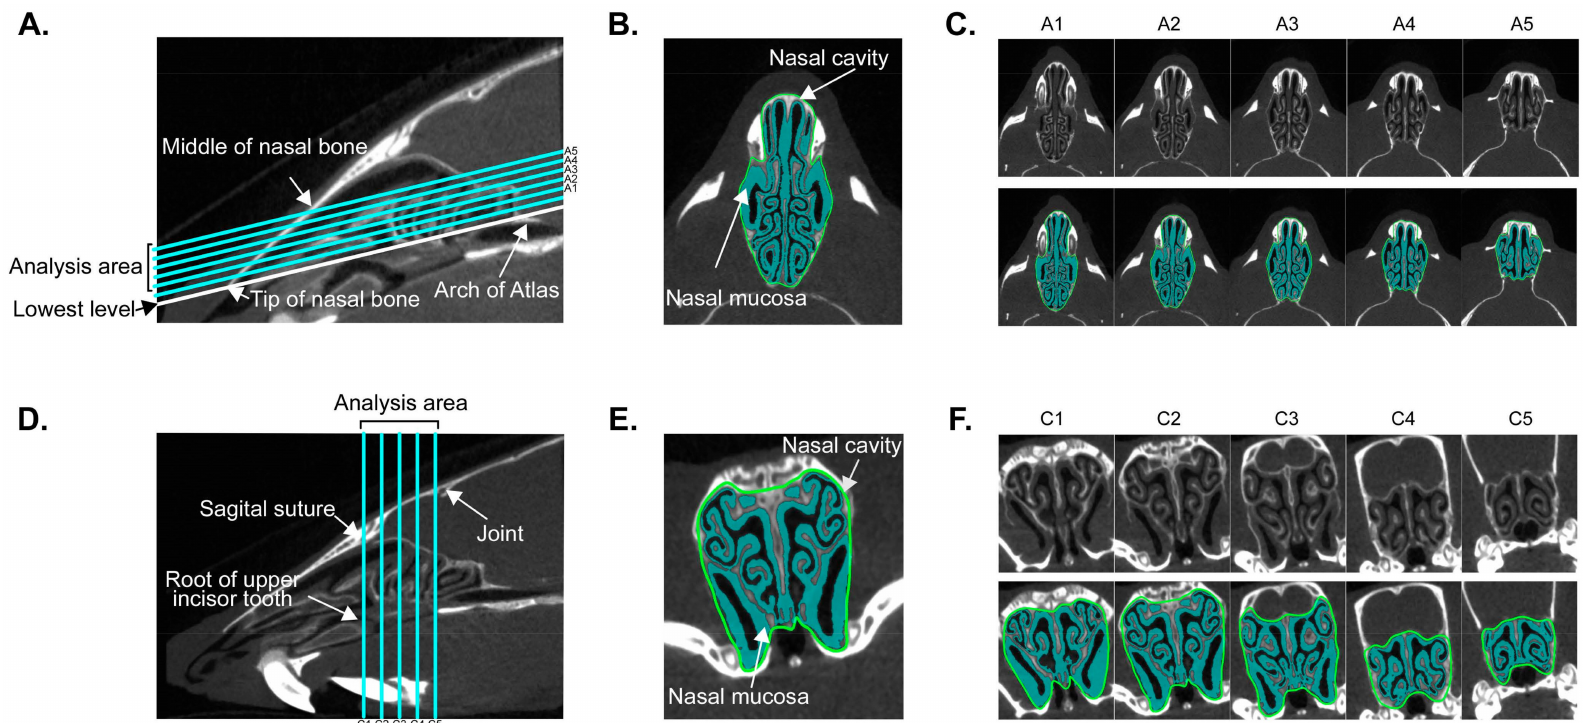
Figure 1. Landmark definition in micro-computed tomography (CT) imaging. A and D indicate segmentation of the axial and coronal axes on sagittal CT images of nasal cavity, respectively. B and E show the region of interest (ROI) on slice A2 in axial and C2 in coronal axis, respectively. C and F indicate serial CT images in raw data and ROI on axial (A1–A5) and coronal (C1–C5) axes,